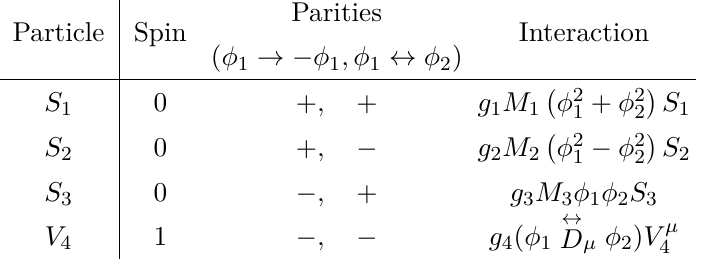
Figure 1. Left: the positivity cone in the vectors are labeled in different colors. Right: a cross section of this cone, which is a quadrilateral. The cross section is obtained with a hyperplane C intersecting the